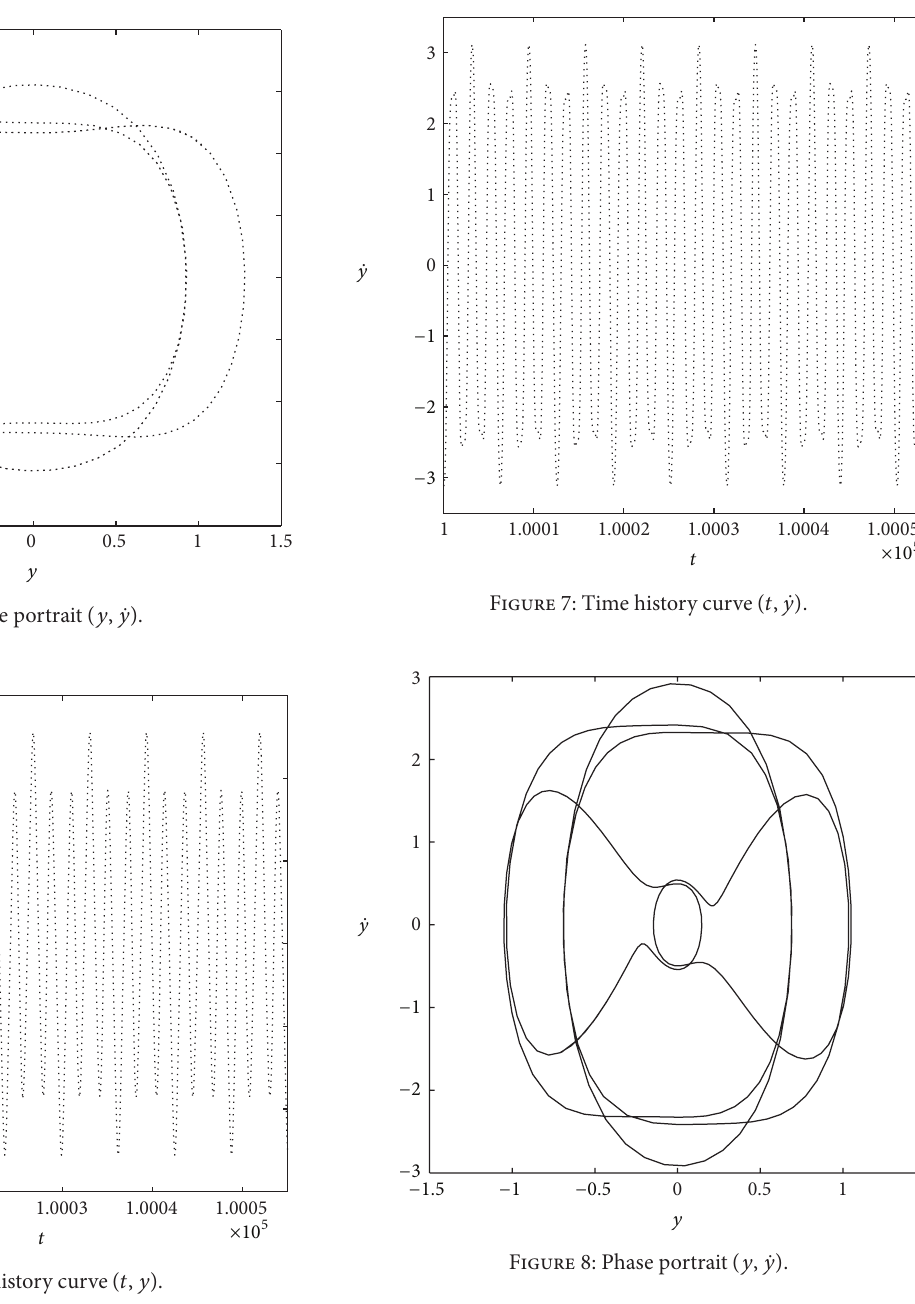
Figure 6: Time history curve (𝑡,𝑦) .